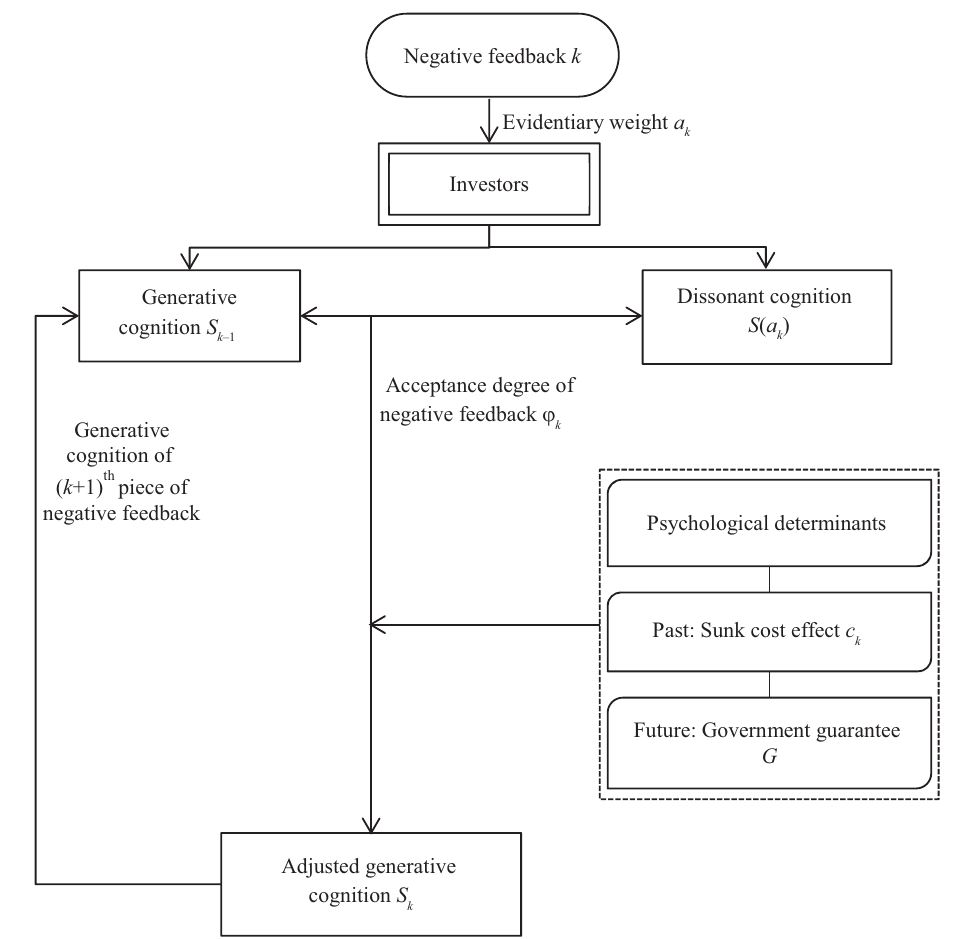
Figure 5. Belief-adjustment model process of EOC